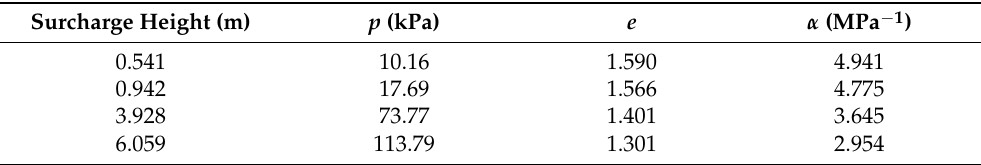
Table 6. Calculation results of the pressure, void ratio, and compressibility coefficient for the K41+277 section of the